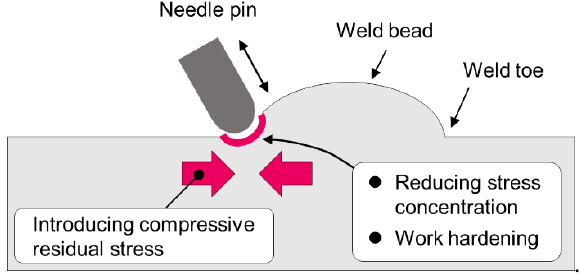
Figure 1. Schematic view of needle peening (NP) at the weld toe. NP introduces beneficial compressive residual stresses in the surface layer around the weld toe by repeatedly striking the surface with a needle pin.